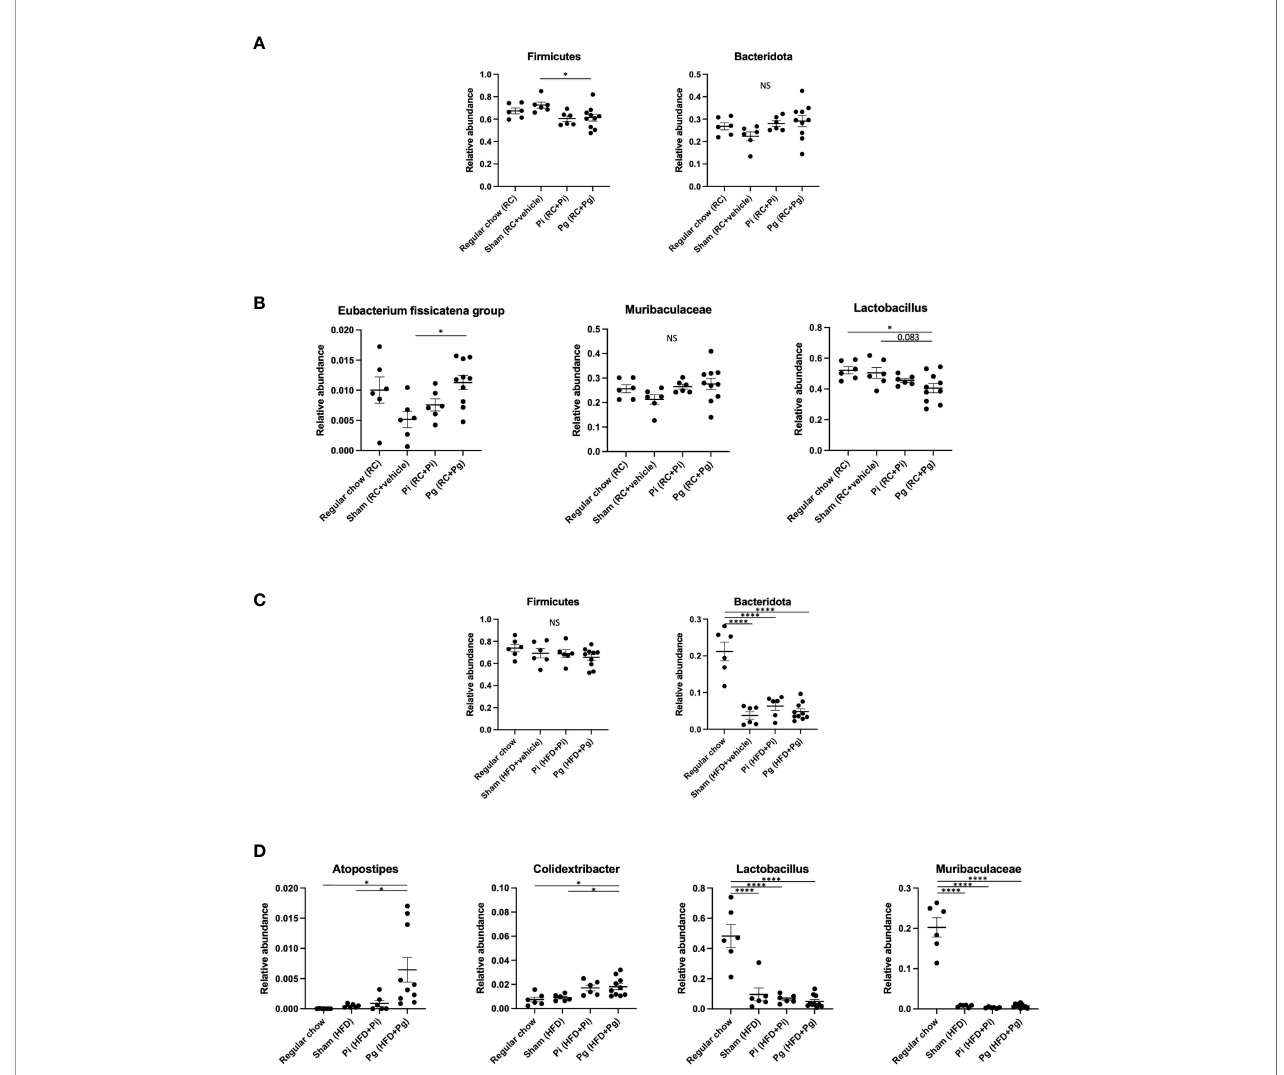
FIGURE 5 | Effect of bacterial administration (TP2) and additional diet change (TP3) on the gut microbiota composition (n=6-10/group). Fecal samples from mice that received the various treatments were subjected to 16S rRNA sequencing. (A) Relative abundance of phyla Firmicutes and Bacteridota at TP2. (B) Relative abundances of characteristic genera in each experimental group at TP2. (C) Relative abundance of phyla Firmicutes and Bacteridota at TP3. (D) Relative abundances of characteristic genera in each experimental group at TP3. Data are expressed as the mean ± standard error of the mean (SEM). P values were calculated using one-way ANOVA with Tukey ’ s multiple comparisons test. * P <0.05, **** P <0.0001. NS, not signi fi